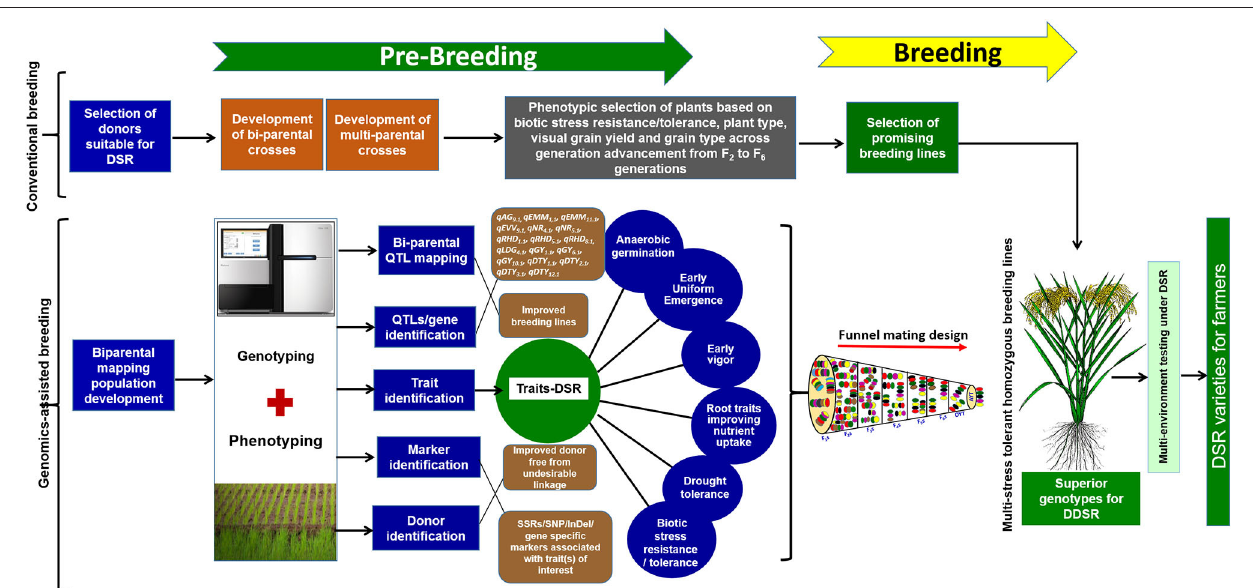
FIGURE 1 | Detailed schematic representation of the pre-breeding steps, use of genomics-assisted breeding following funnel mating design to assemble the targated QTL/genes to develop multi-stress-tolerant homozygous breeding lines suitable for direct-seeded cultivation